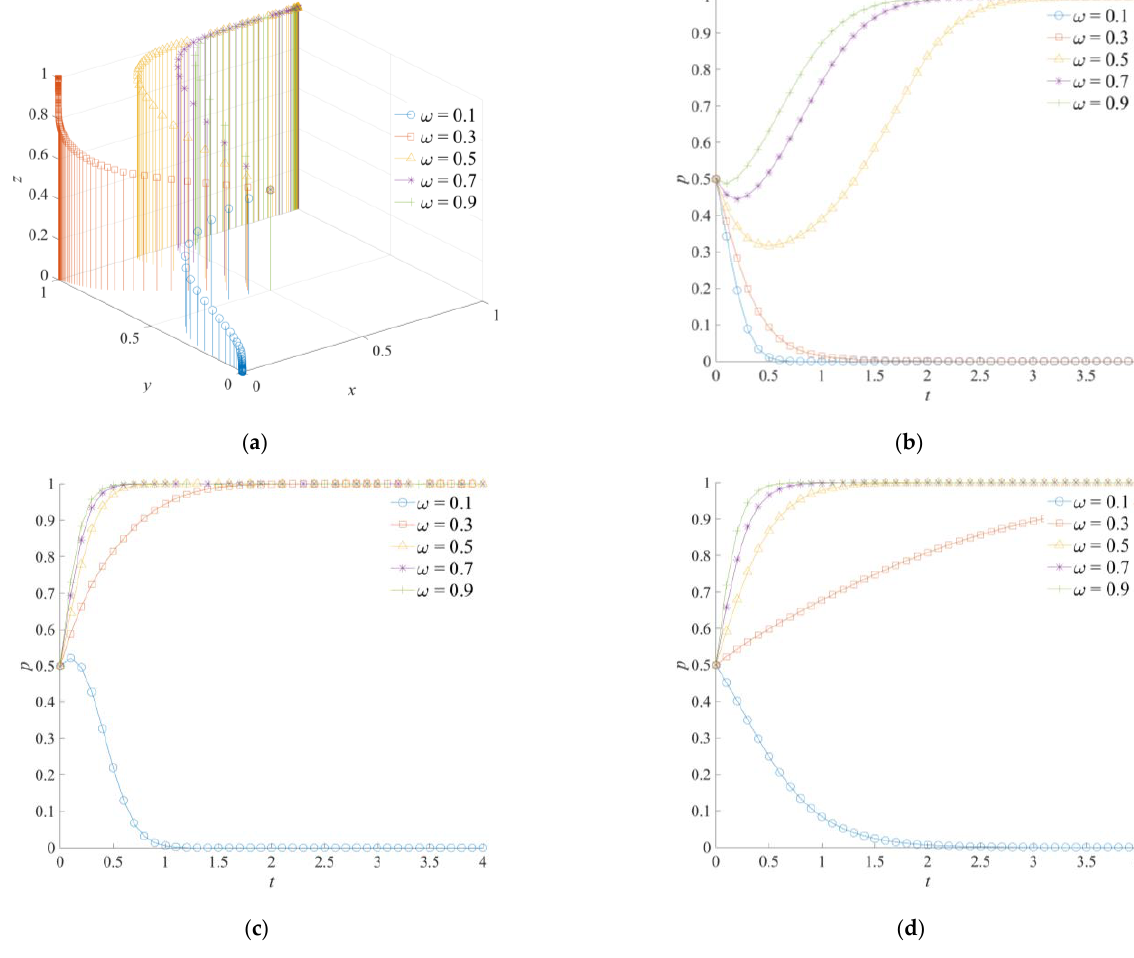
Figure 10. Evolution trajectory of the game system under different emergency dispatching degrees of the central government: ( a ) The influence of ω on the evolution of the game system; ( b ) the influence of ω on the evolution of the local government; ( c ) the influence of ω on the evolution of the neighboring government; ( d ) the influence of ω on the evolution of the central government.